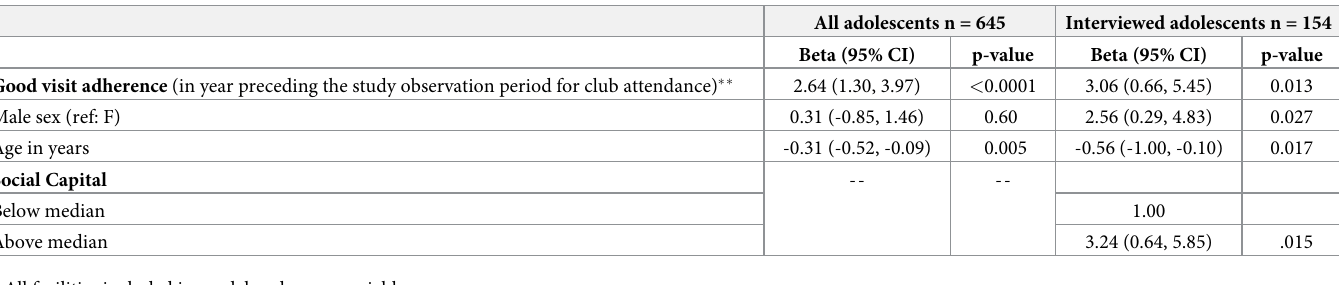
Table 4. Factors associated with annual number of club meetings attended: Facility � , sex and age adjusted linear